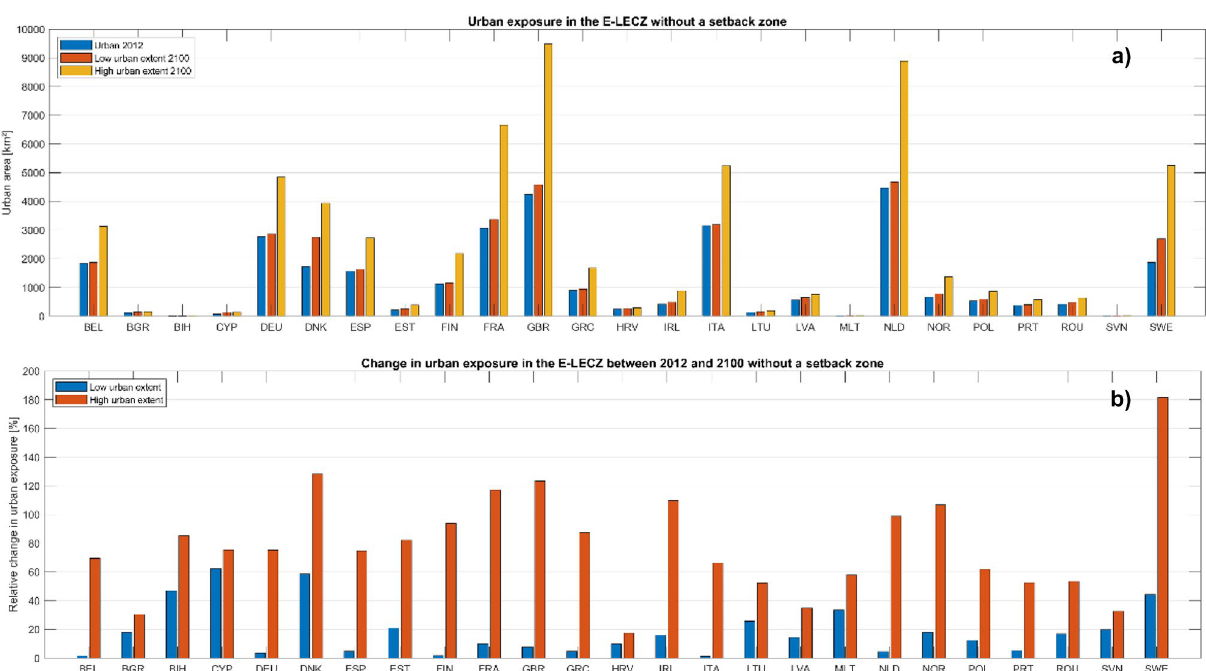
Figure 4. Urban exposure in the E-LECZ without the implementation of a coastal setback zone. ( a ) Shows the absolute values of urban areas in the E-LECZ in 2012 as well as the potential urban extent under a low and